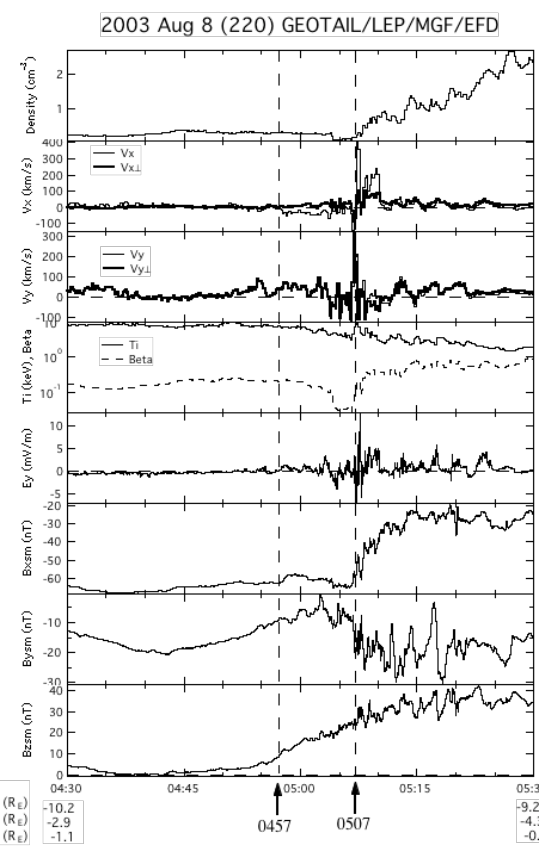
Figure 8 Fig. 8. The measurements from the Geotail